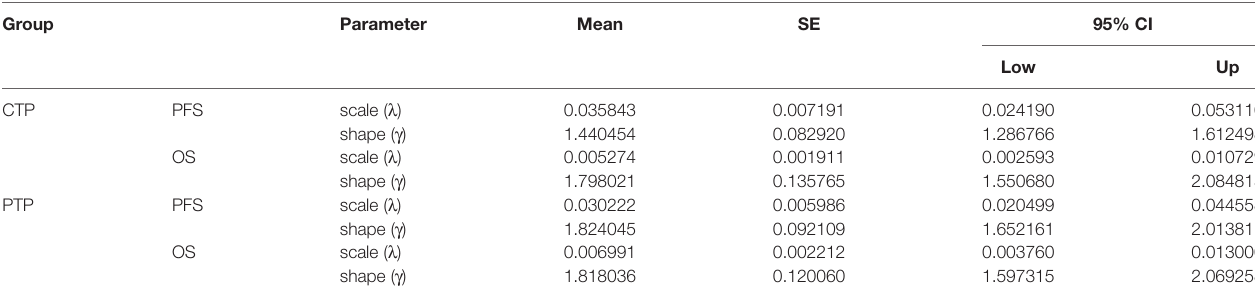
TABLE 1 | Weibull parameters of model estimated for progression-free and overall survival curves.